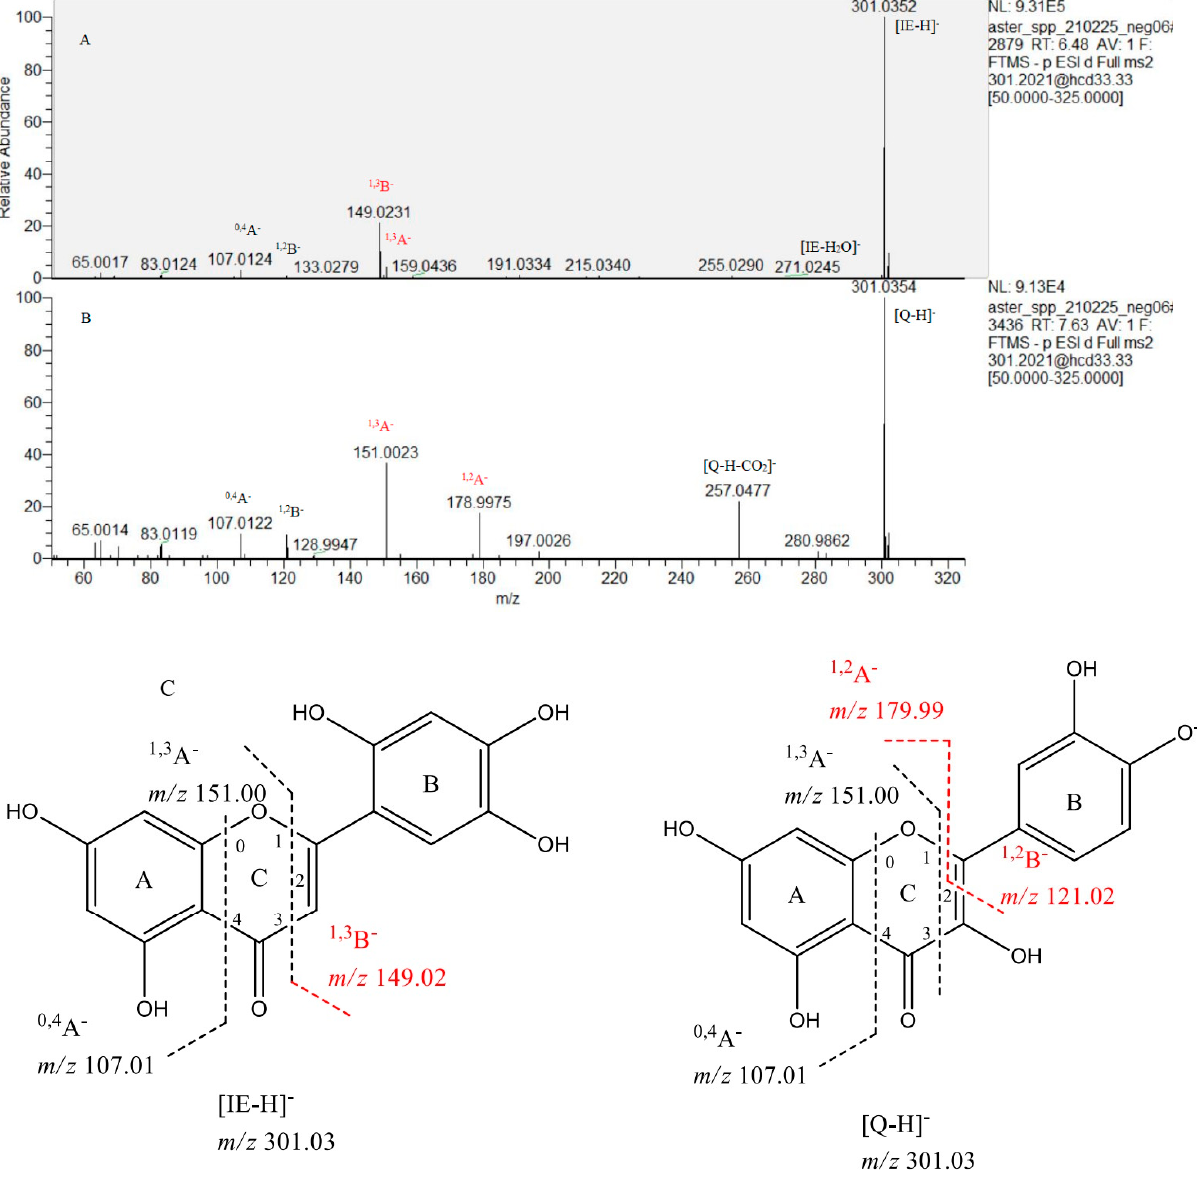
Figure 2. ( − ) ESI/MS-MS spectrum of isoetin ( 85 ) ( A ); quercetin (92) ( B ); possible fragmentation and Figure 2. (-) ESI/MS-MS spectrum of isoetin ( 85 ) ( А ); quercetin (92) ( B ); possible fragmentation and preliminary structure of isoetin ( 85 ) and quercetin ( 92 ) ( C preliminary structure of isoetin ( 85 ) and quercetin ( 92 ) ( C ).